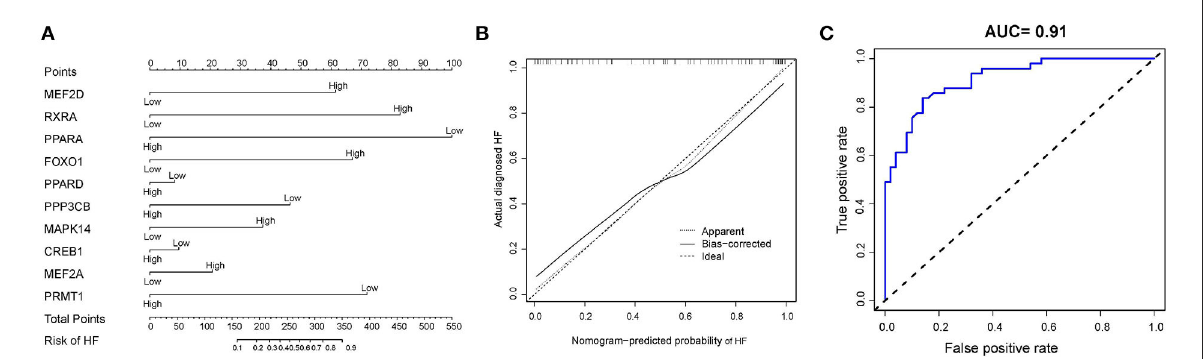
FIGURE6 Construction of a nomogram model for HF diagnosis in training cohort (GSE66360). (A) The nomogram was used to predict the occurrence of HF. (B) Calibration curve to assess the predictive power of the nomogram model. (C) The receiver operating characteristic (ROC) analysis of nomogram.